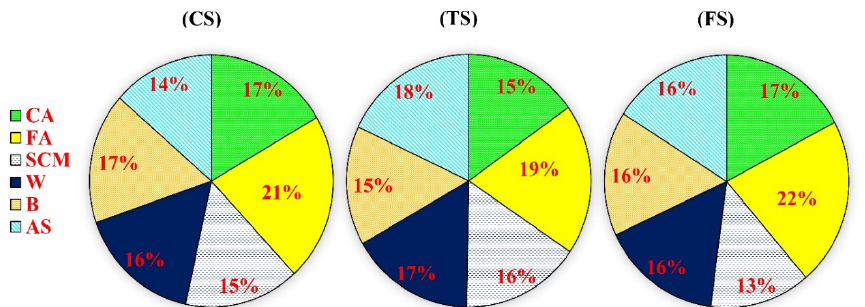
Figure 10. Sensitivity analysis of variable importance .